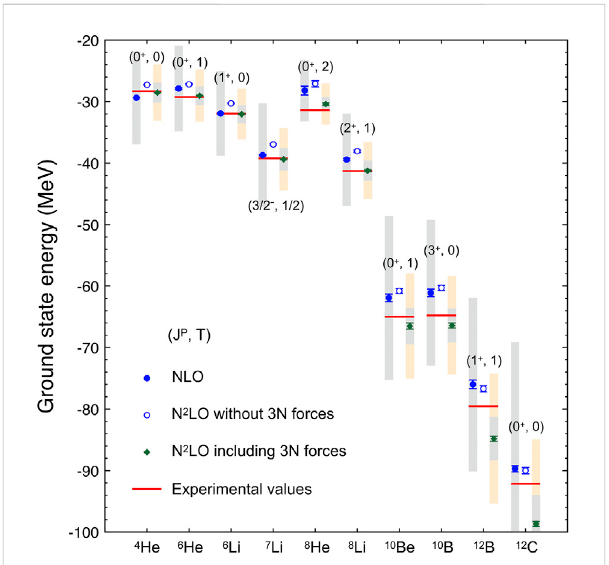
Predictions for ground-state energies of selected light nuclei using interactions up to next-to-next-to-leading order in χ EFT. The grey (coral) bands indicate 68% (95%) credible intervals for the theoretical uncertainty stemming from truncating the χ EFT expansion. Figure from Ref. [121], where additional details can be